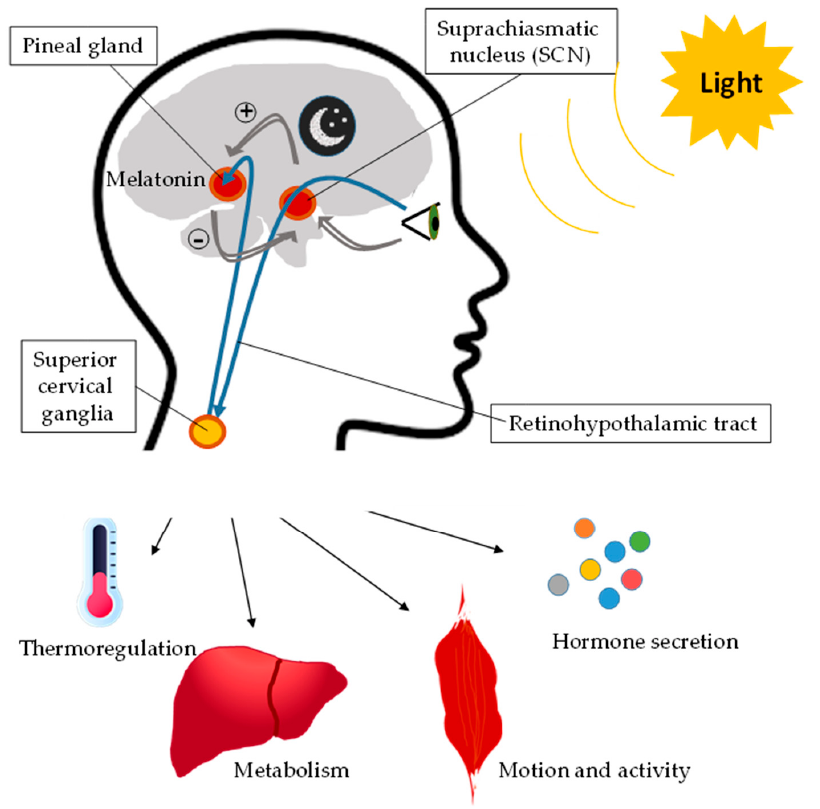
Figure 2. Effect of light on biological rhythms. Light regulates biological rhythms through the activation of the suprachiasmatic nucleus, which actives superior cervical ganglia, which triggers different signaling pathways in the body, such as pathways that modulate thermoregulation, metabolism, motion, activity, and hormone secretion. In the dark period, the pineal gland synthesizes melatonin, which inhibits the action of the suprachiasmatic nucleus.